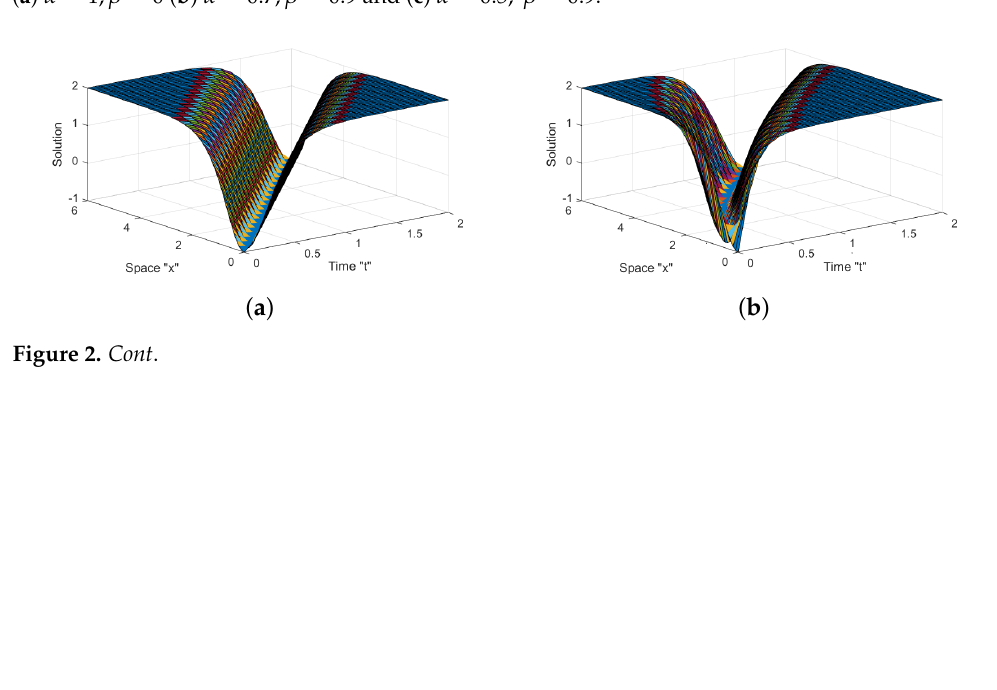
Figure 1. For Equation (21), ( a – c ) with parameters k = − 1, ξ 1 = 1, ξ 2 = 2, ξ 3 = − 3, ξ 4 = 2, λ = − 3, x ∈ [ 0,6 ] , t ∈ [ 0,2 ] , y = ω = 0.5, z = 2 displays the 3D representations and ( d ) displays 3 the 2D plot for various values of α at t = 1.5; there is no overlap between the curves of the solution.